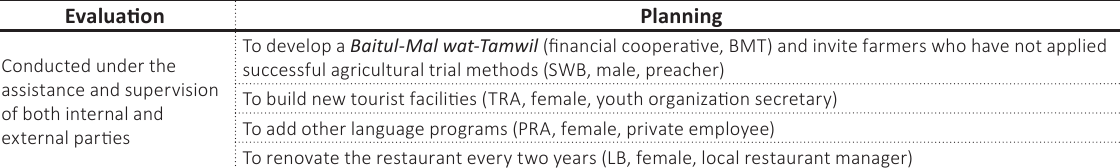
Table 5. Evaluation and planning of the sharia economic